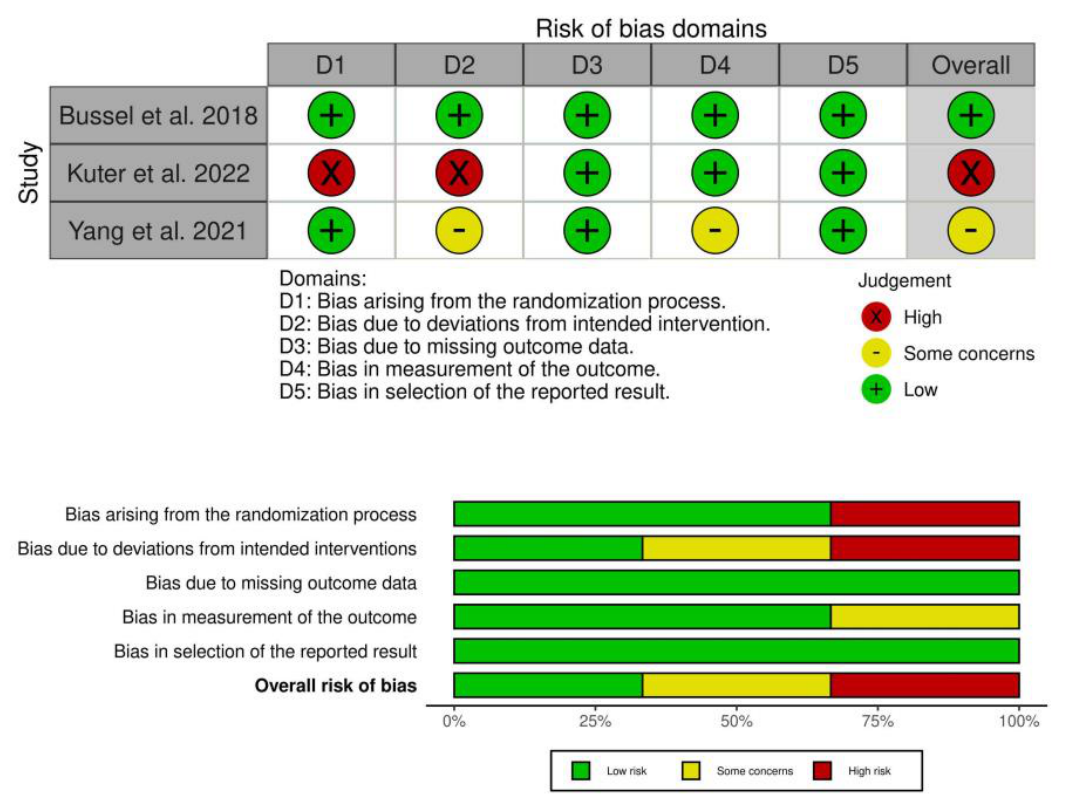
Figure 2. Risk of bias in included clinical trials. Table 1. Baseline characteristics of patients in included clinical